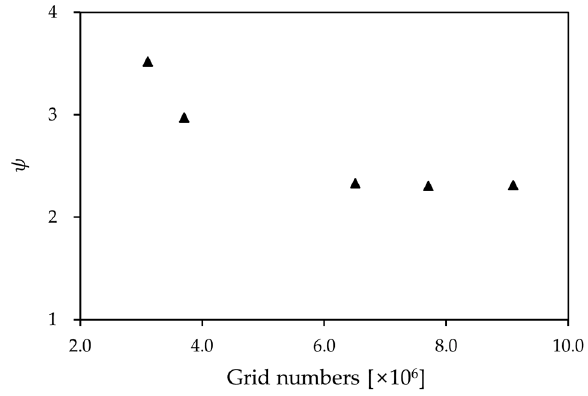
Figure 8. Performance curve for grid dependence.